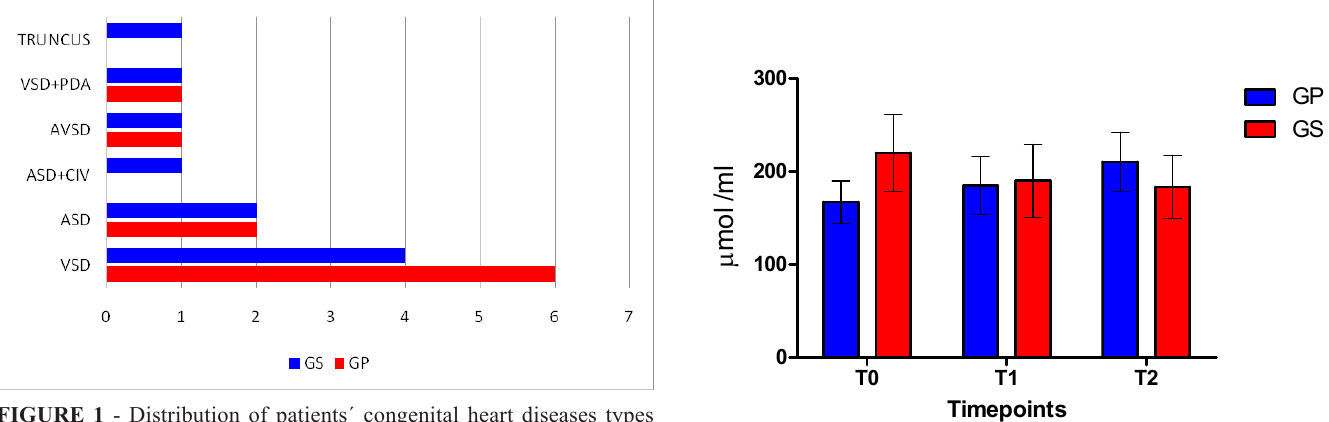
FIGURE 1 - Distribution of patients´ congenital heart diseases types and percentiles.